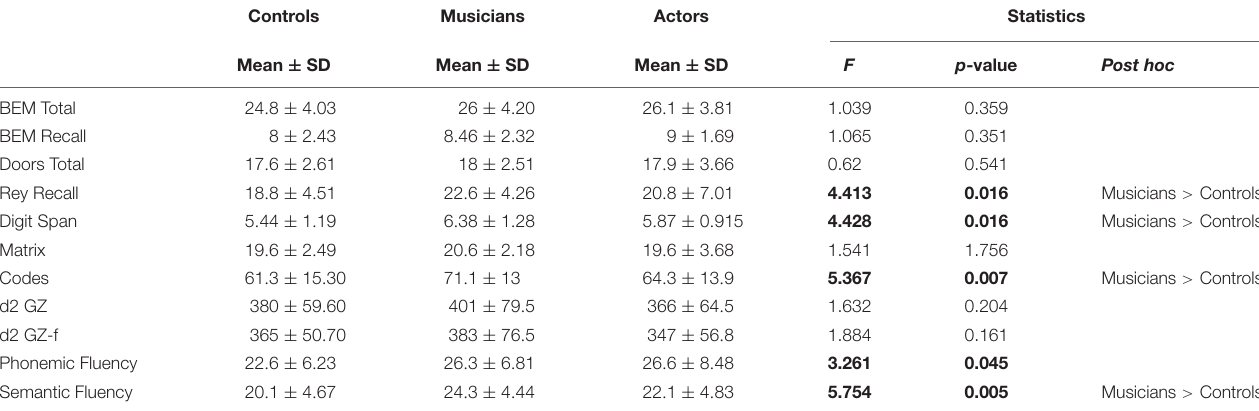
TABLE 5 | Statistical results of MANCOVA limited to older adults.